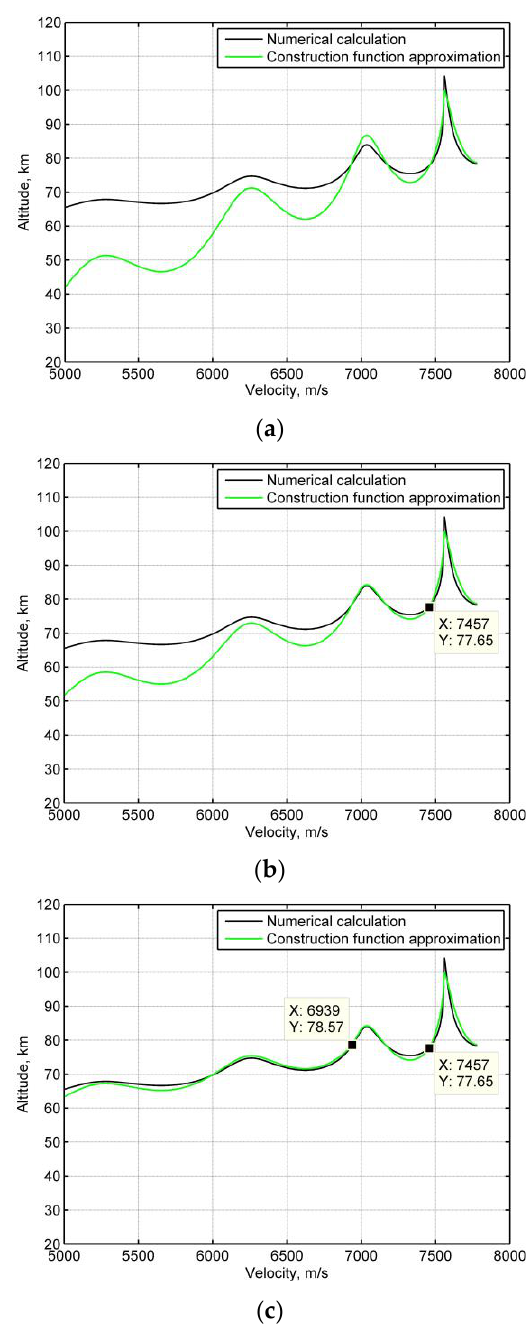
Figure 2. The phugoid oscillation motion trajectories by two prediction methods. ( a ) Fixed initial parameters, ( b ) initial parameters are updated for the second skip, ( c ) initial parameters are updated for the third skip.